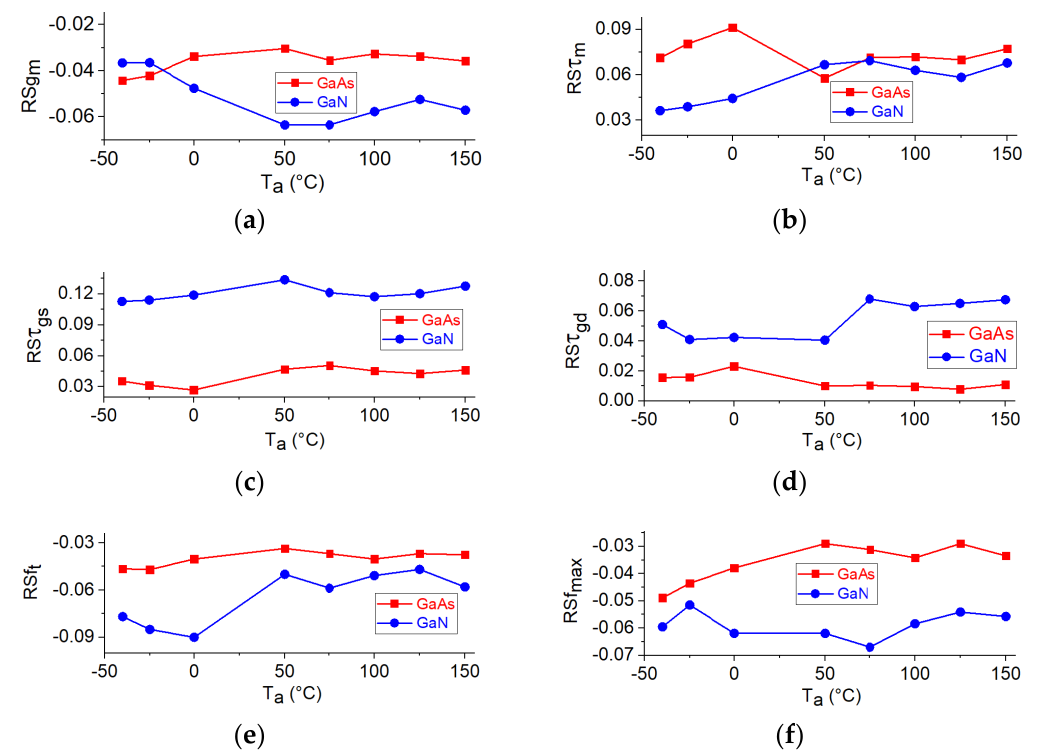
Figure 11. Behavior of the relative sensitivities of the intrinsic transconductance, the intrinsic time constants, and the RF figures of merit versus T a for the two studied devices. The illustrated bias points are: V ds = 3 V and V gs = − 0.1 V for the GaAs HEMT and V ds = 9 V and V gs = −4 V for the GaN HEMT.